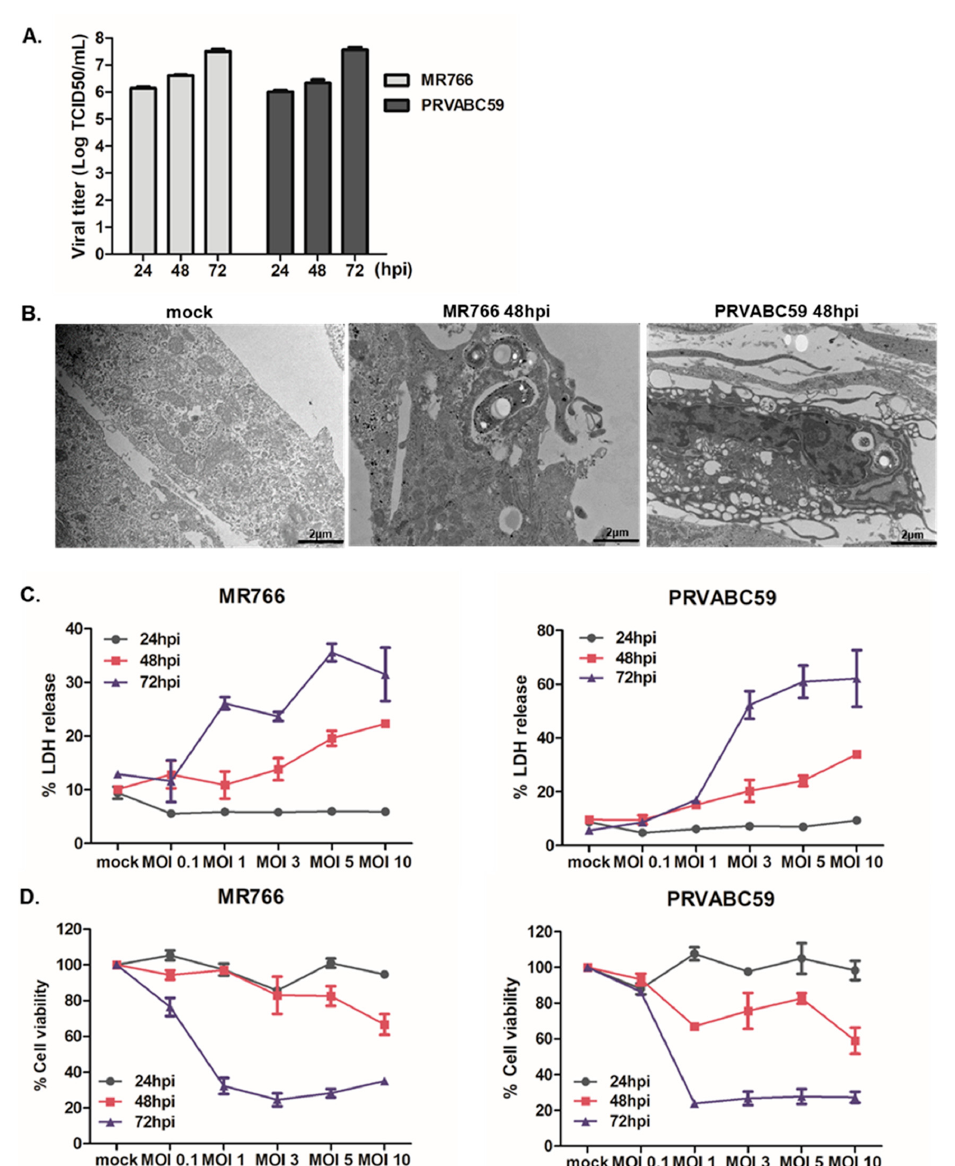
Figure 1. Cell viability and death during Zika virus (ZIKV) infection of hNPCs. ( A ) Viral titers were measured by TCID50 assay. Supernatant was collected from hNPCs infected with ZIKV (MR766 or PRVABC59) at MOI of 3 for various timepoints. TCID50 was calculated using the Spearman–Kärber method and expressed as TCID50/mL. Results represent means ±SD of two independent experiments. ( B ) hNPCs were infected with ZIKV (MR766 and PRVABC59) at MOI of 3. Transmission electron microscopy shows the presence of apoptotic cell death. ( C ) % LDH release was measured in cell supernatant of mock-infected cells vs. ZIKV-infected cells. Values were normalized to mock-infected cells. ( D ) Cell viability was measured at 24, 48, and 72 hpi by CellTiter Glo luminescence assay and normalized to mock-infected cells. Values represent the mean and standard deviation of three independent experiments.